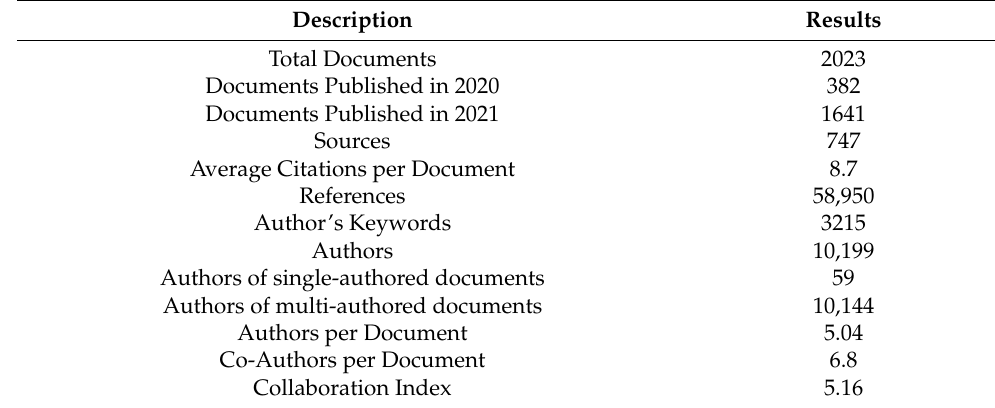
Table 1. Summary of bibliometric indicators on physical activity and coronavirus disease (2020–2021).